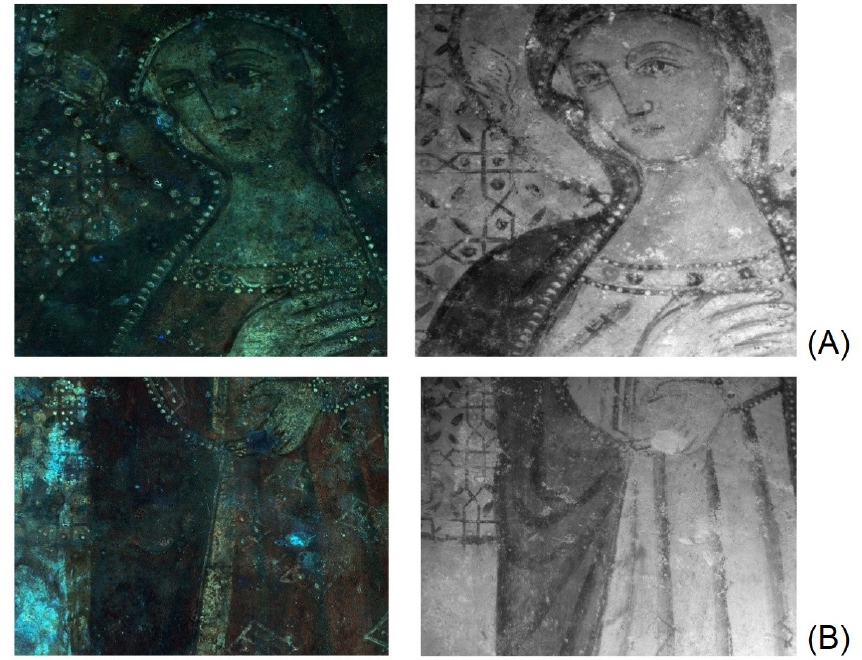
Figure 4. Details (at different magnifications) of the (from left) UVF and IR images for the compari- son of the diagnostic information obtained from the imaging techniques: ( A ) Detail of the face and the halo; ( B ) detail of the dress and of the background floral-geometric decoration. halo; ( B ) detail of the dress and of the background floral-geometric